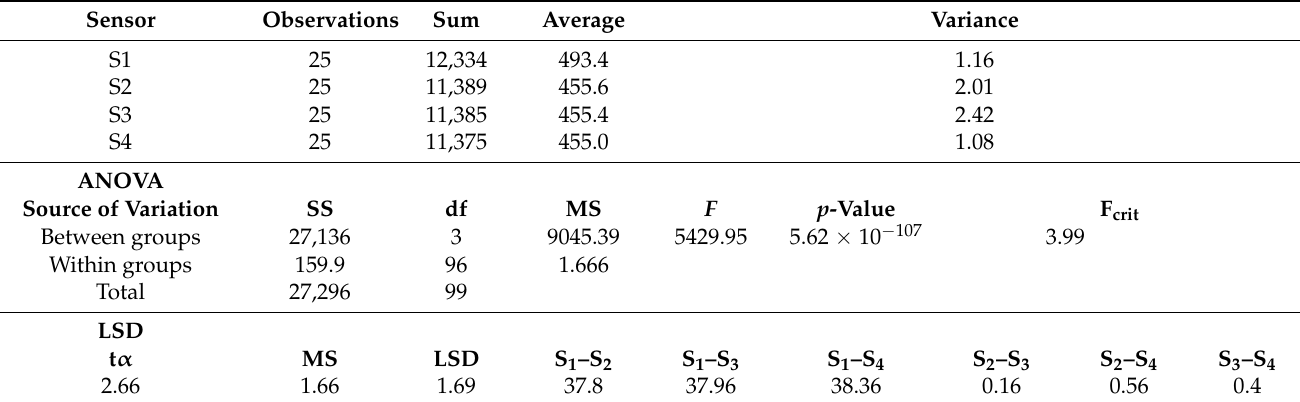
Table 4. ANOVA results for the 25 replications of the response measurements for different tested moisture sensors at 40% soil moisture content.